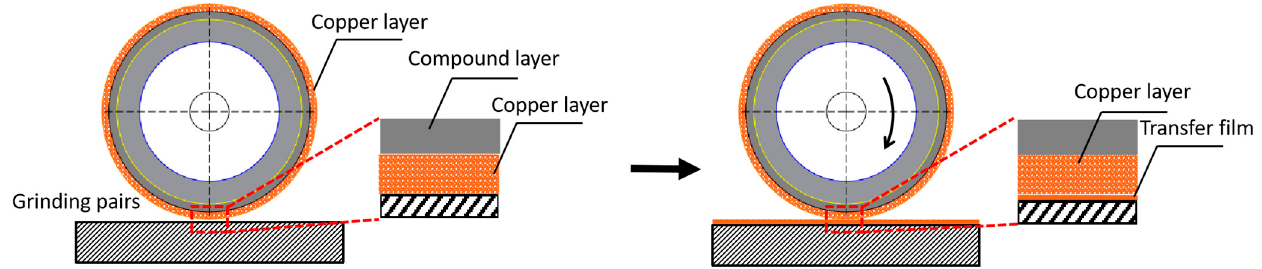
Figure 13. The self-lubricating and antifriction mechanism of nano-Cu/microalloyed gradient coat-